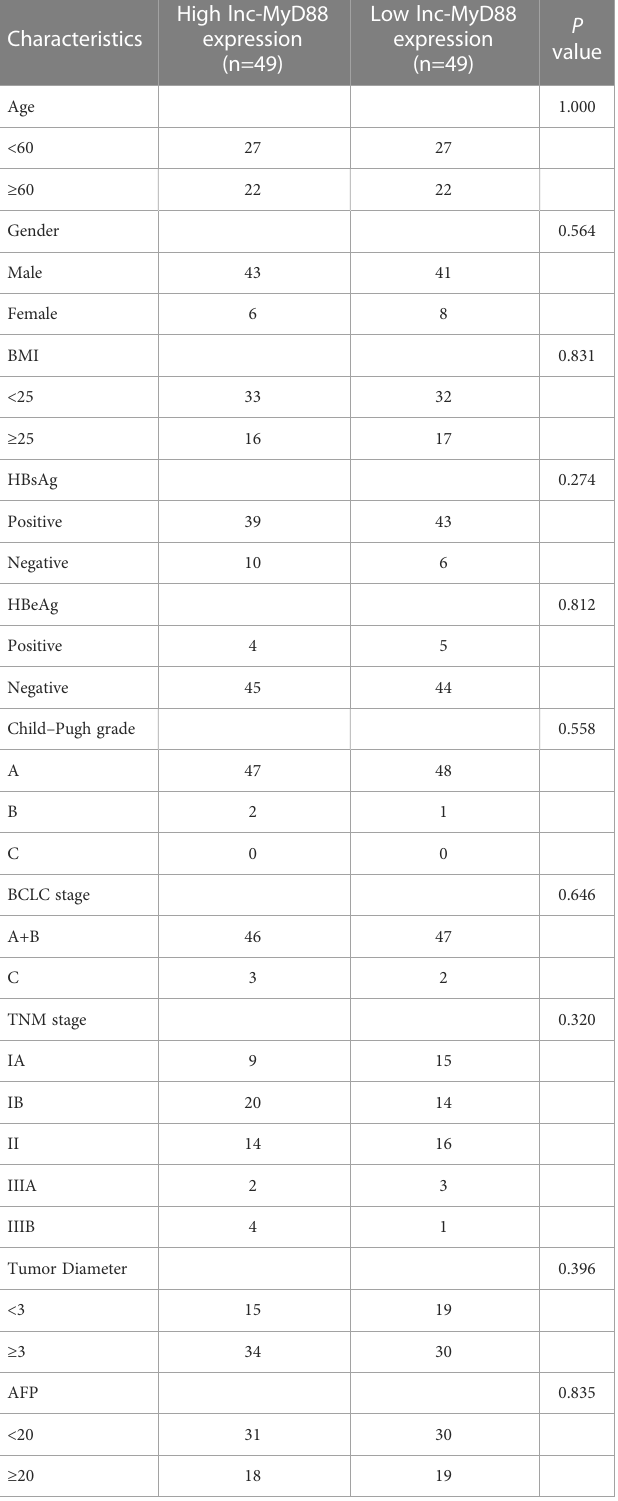
TABLE 8 The association between the lnc-MyD88 expression levels and various clinicopathological features in HCC.